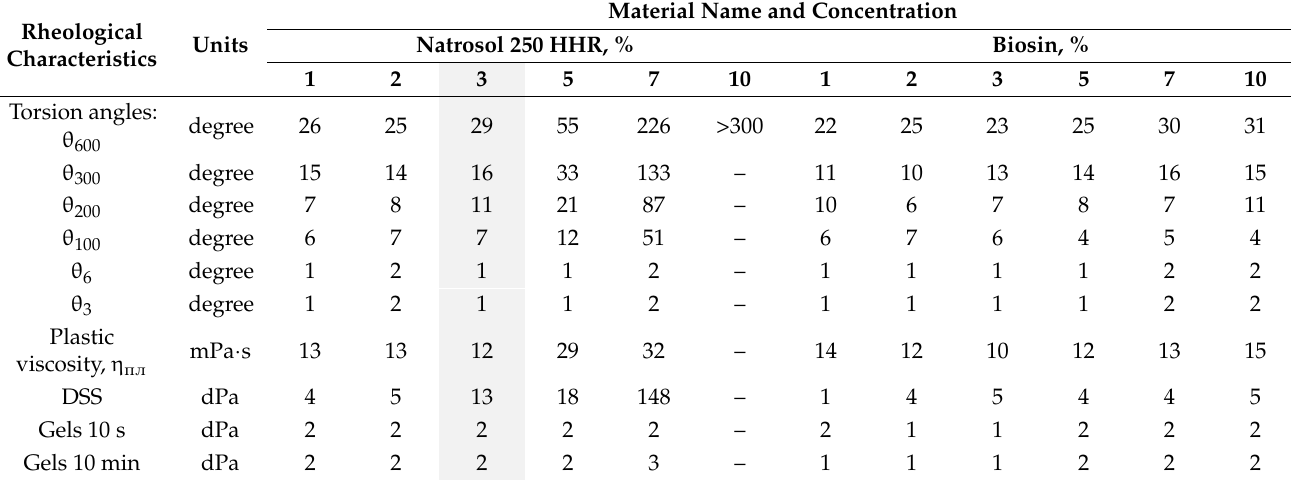
Table 4. Study of the effect of polymer concentration on the structural and rheological characteristics of brine at a temperature of 35 ◦ C and a pressure of 8.1 MPa.